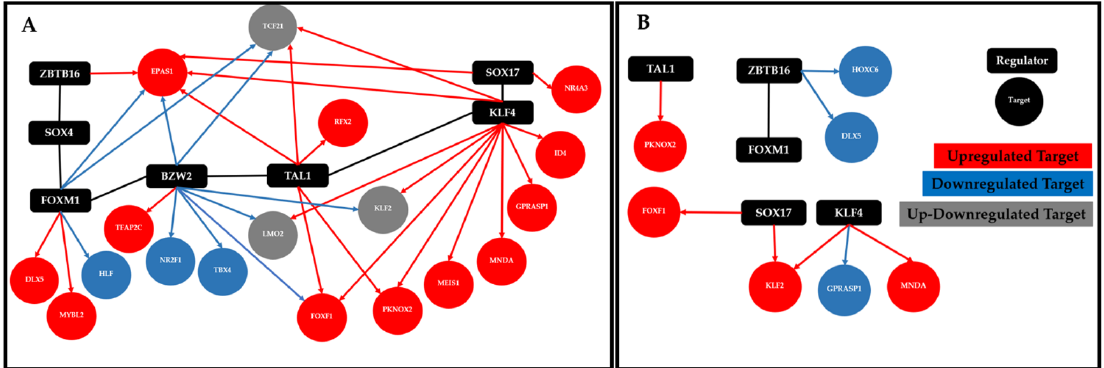
Figure 8. Transcriptional regulatory network of the top seven deregulated transcription factors (squares) over the other nineteen frequently dysregulated transcription factors (circles) in every lung cancer type (( A ). NSCLC and ( A ). SCLC). In blue are the downregulated TFs, and in red are the upregulated TFs.